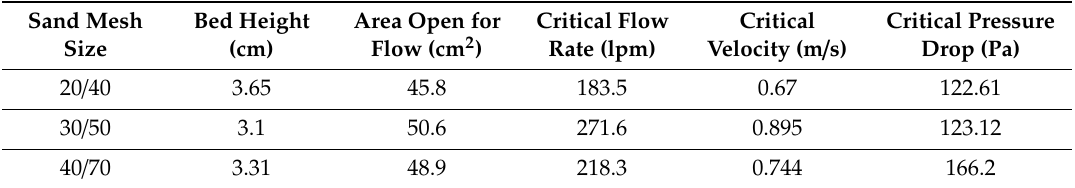
Table 3. Critical velocity required for the particle removal from the untreated sand bed.